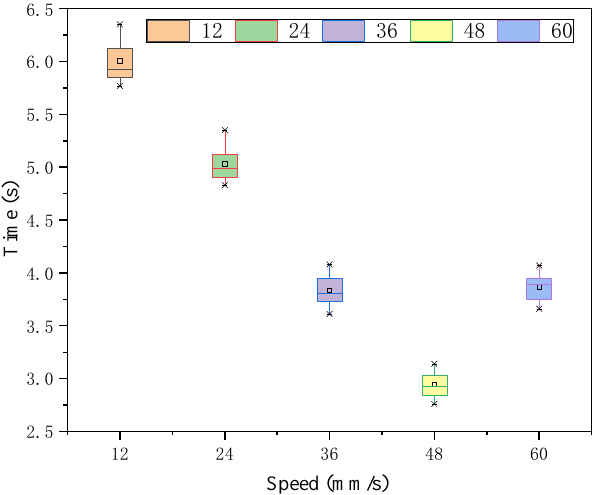
Figure 13. Response time of each speed target under intensity 197 stimulation. Table 7. Time statistic value under intensity 197.